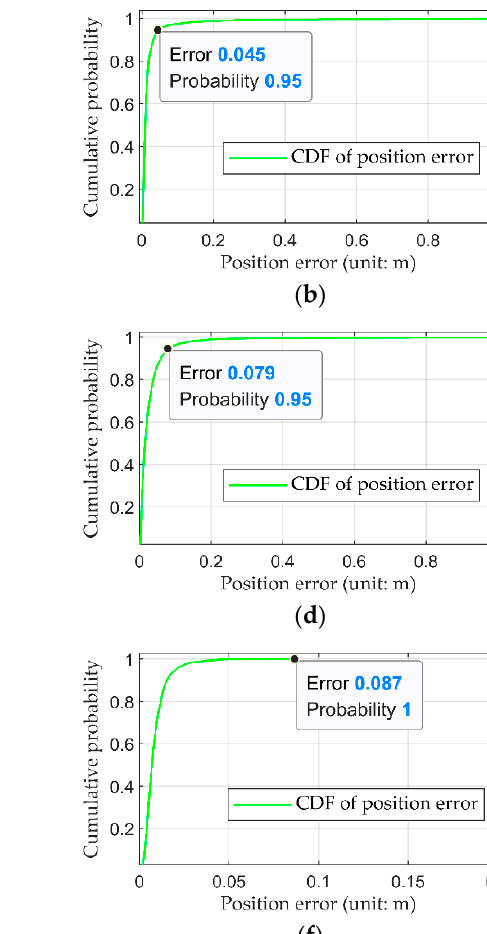
line of each sub-figure represents the CDF curve. The vertical coordinate represents the cumulative probability of position error.